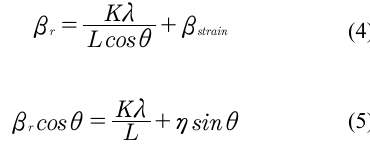
Figure 1. The diagram of CaCO